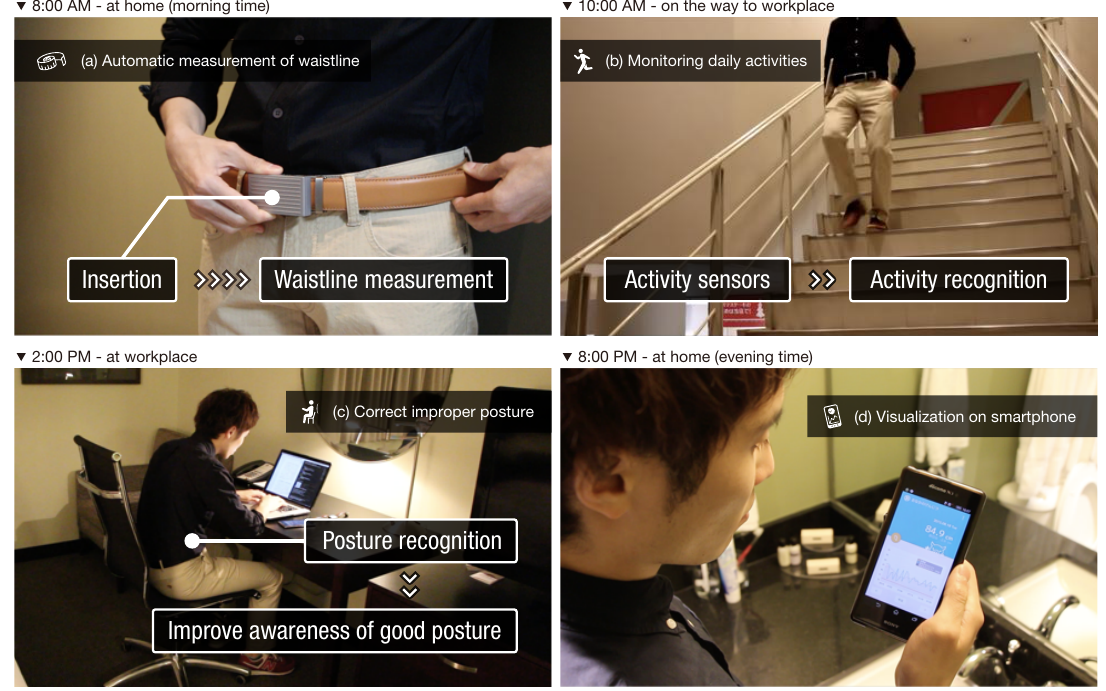
Figure 2. Use case scenario of WaistonBelt